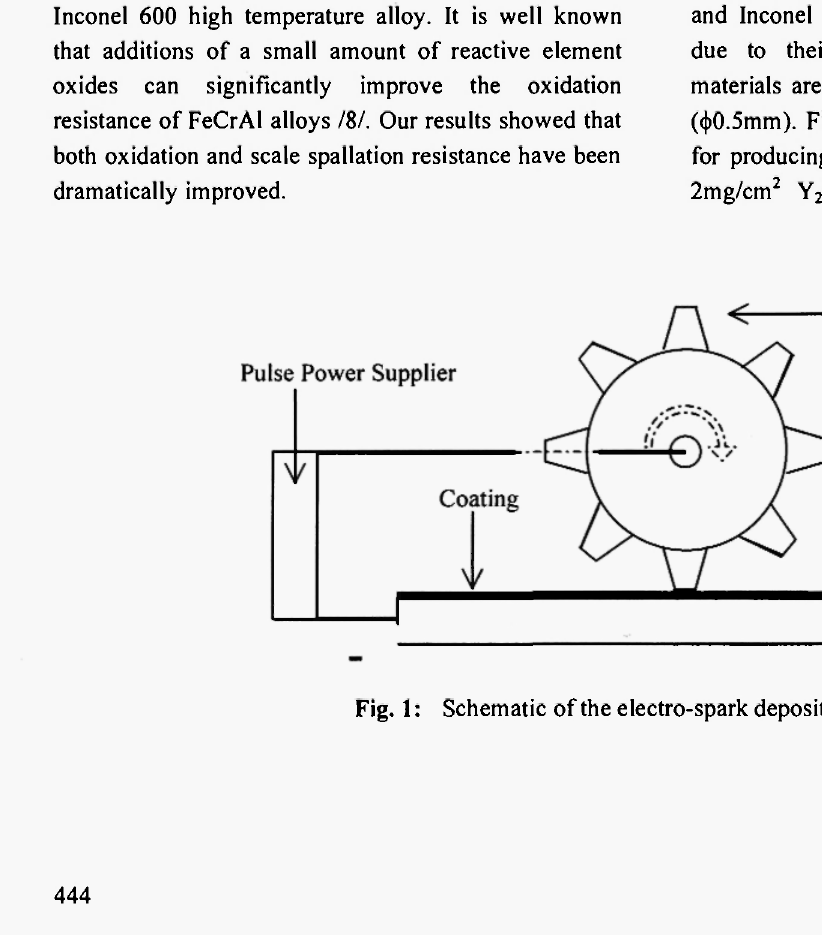
Fig. 1 : Schematic of the electro-spark deposition